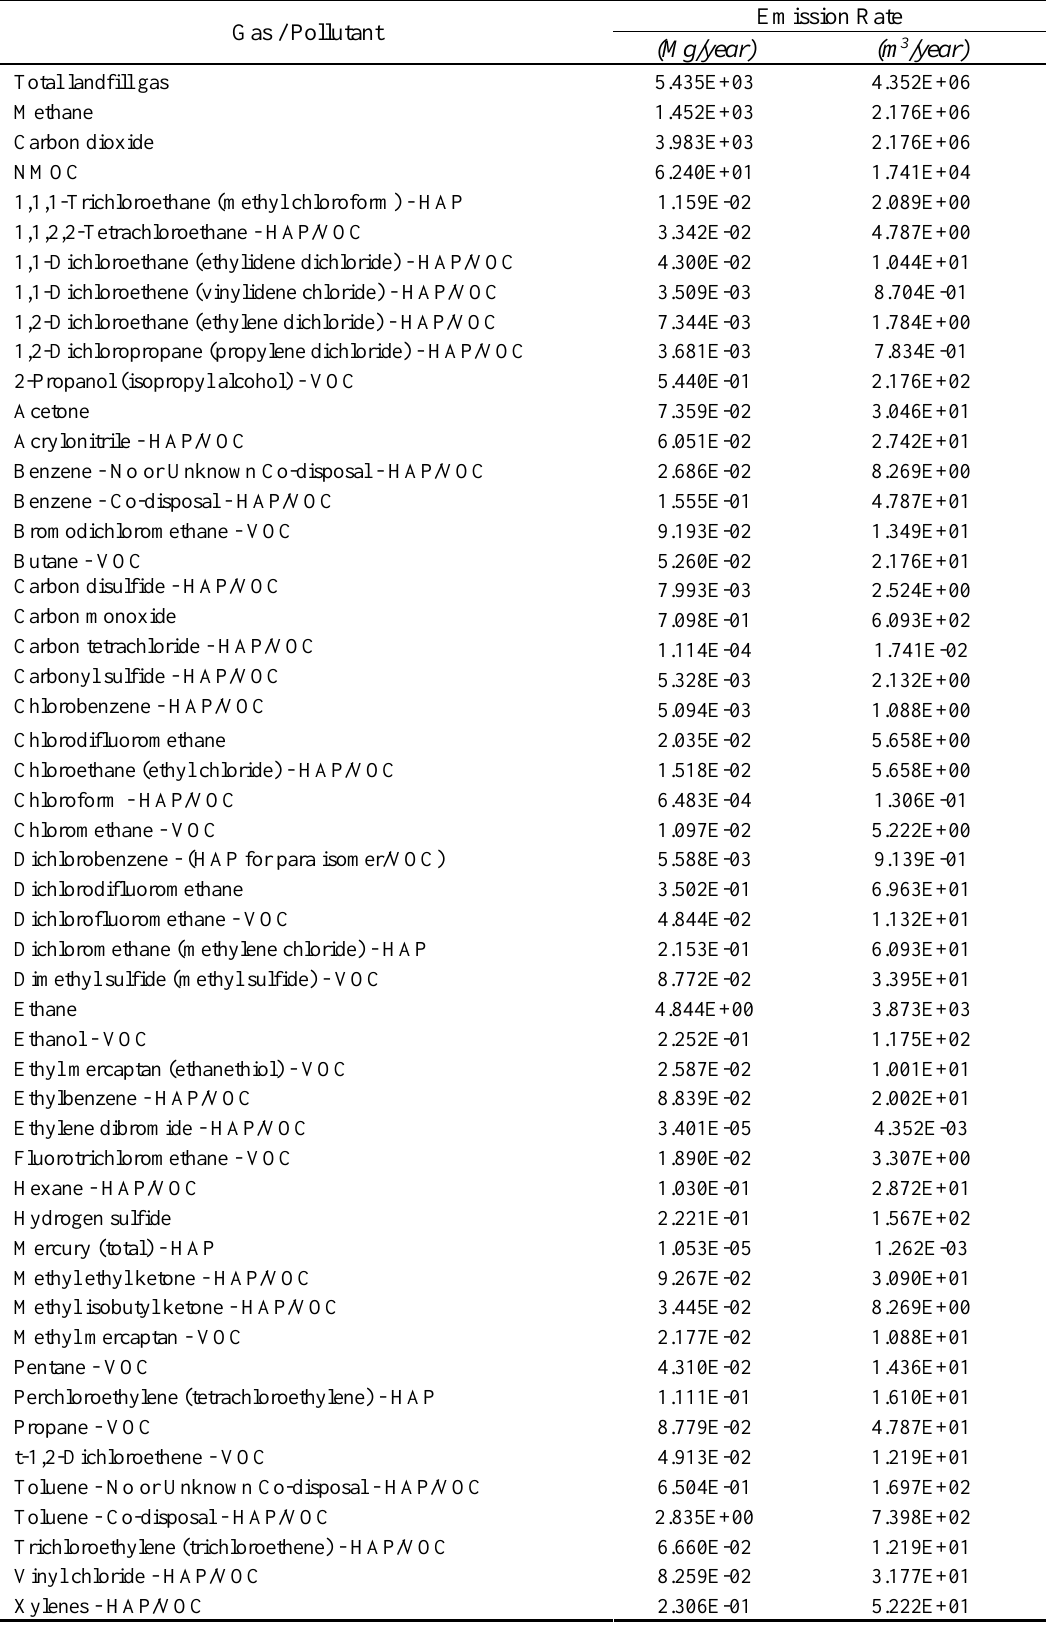
Table 4. The amount of gases and pollutants produced in the province's landfills in 2037, Chaharmahaal and